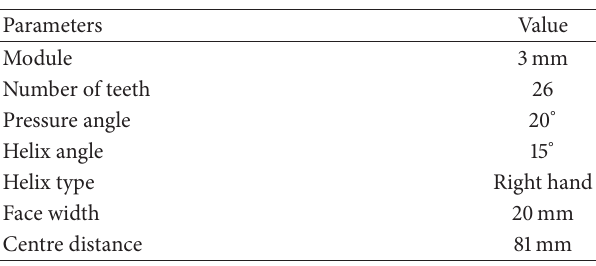
Table 2: Helical gear specifications.